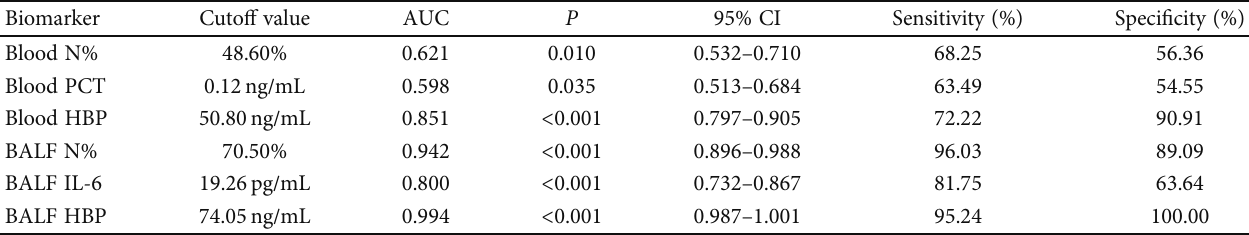
Table 3: Performance characteristics of biomarkers in blood and BALF for predicting bacterial pneumonia. Biomarker Cuto ff